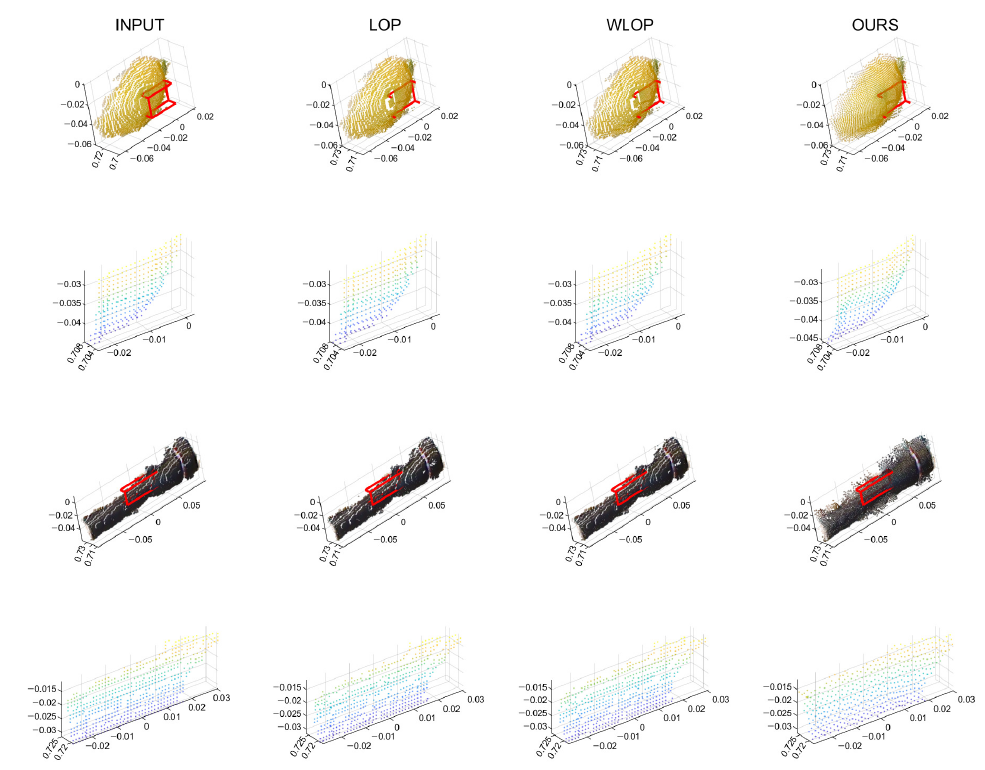
Figure 19. Qualitative results for real data sets. The first row shows the resampled results of Lemon. The second row shows enlarged views of the first row. The third row shows the resampled results of Flashlight. The fourth row shows enlarged views of the third row. First column: input point cloud; second column: LOP; third column: WLOP; and fourth column: proposed